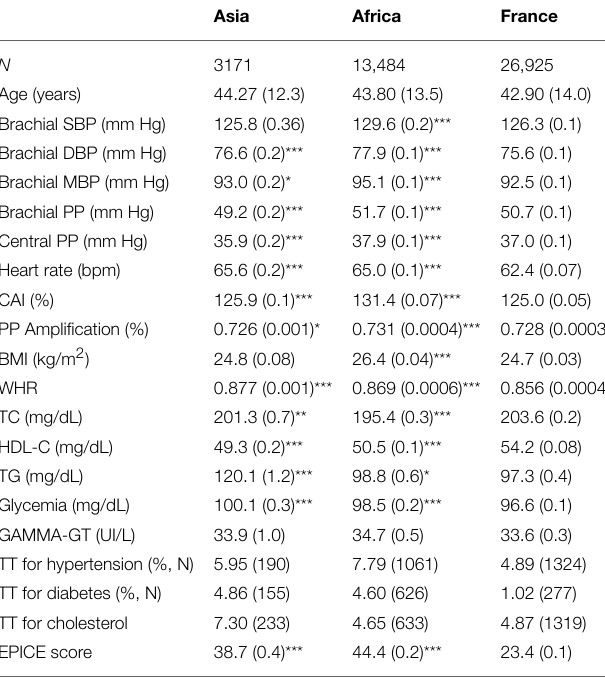
TABLE 3 | Main characteristics (with standard deviation) of individuals with hypertension without diabetes (men and women) according to country of